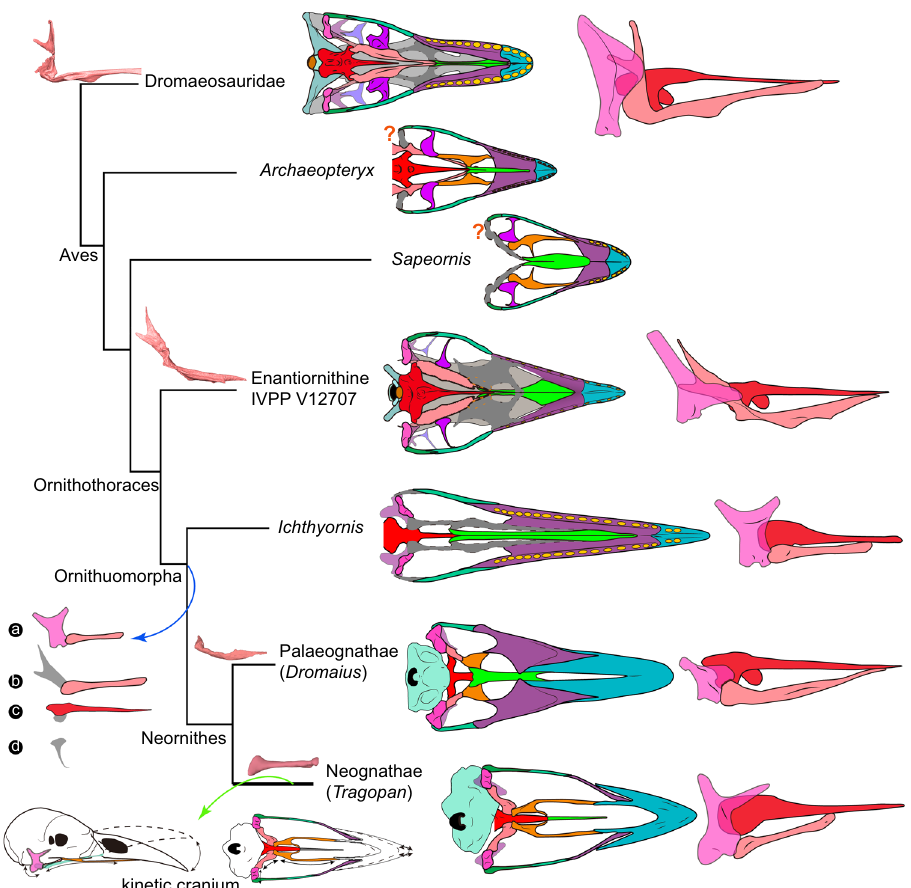
Fig. 4 Evolution of avian palatal complex and cranial kinesis. The tree is simpli fi ed from the current phylogenetic analysis. The digitally reconstructed pterygoid exhibits almost identical morphology between enantiornithine IVPP V12707 and the dromaeosaurid Linheraptor . The modernization of modern avian palatal complex is signi fi ed by four stages, which collectively contribute to the avian cranial kinesis: a acquisition of the condylar-based contact between the quadrate and pterygoid; b – d loss/reduction of the quadrate ramus of the pterygoid ( b ), basipterygoid process ( c ), and ectopterygoid ( d ). The available fossils suggest all those modi fi cations took place close to the origin of Ornithuromorpha. Drawings of palatal complex in ventral views except IVPP V12707 and tragopan are modi fi ed from literature 7,23,46 (shaded regions are not preserved, or reduced). The question marks denote the previous reconstructions of a quadrate-pterygoid articulation in Archaeopteryx and Sapeornis that should be treated with